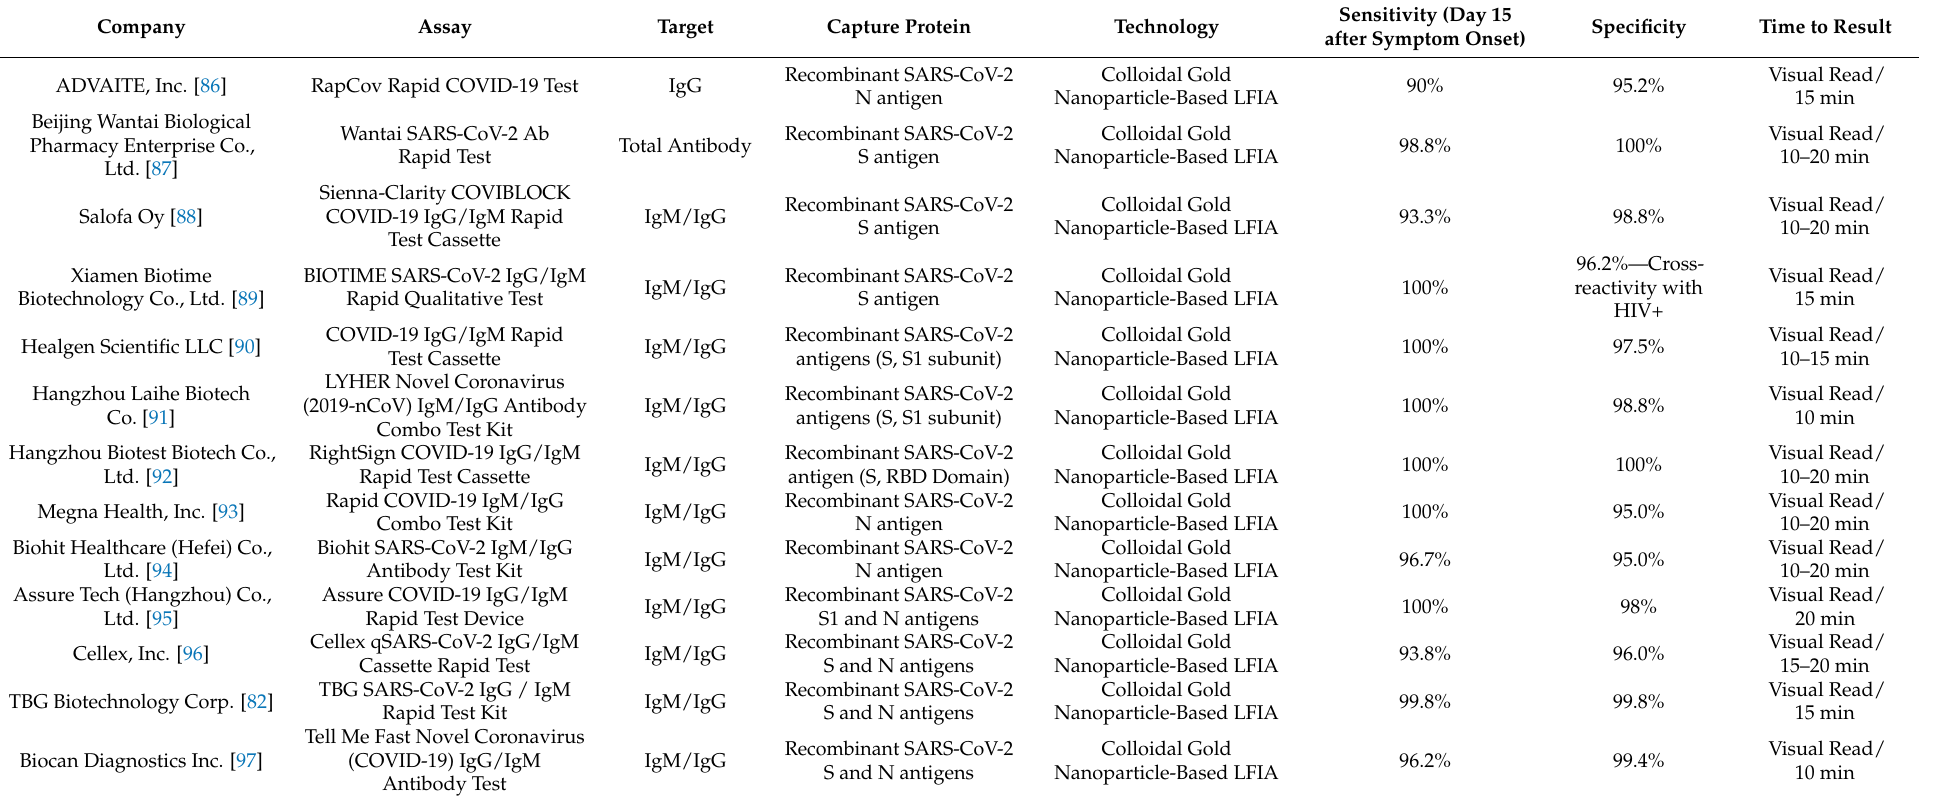
Table 3. Selected rapid LFIA serological tests for COVID-19 detection and their